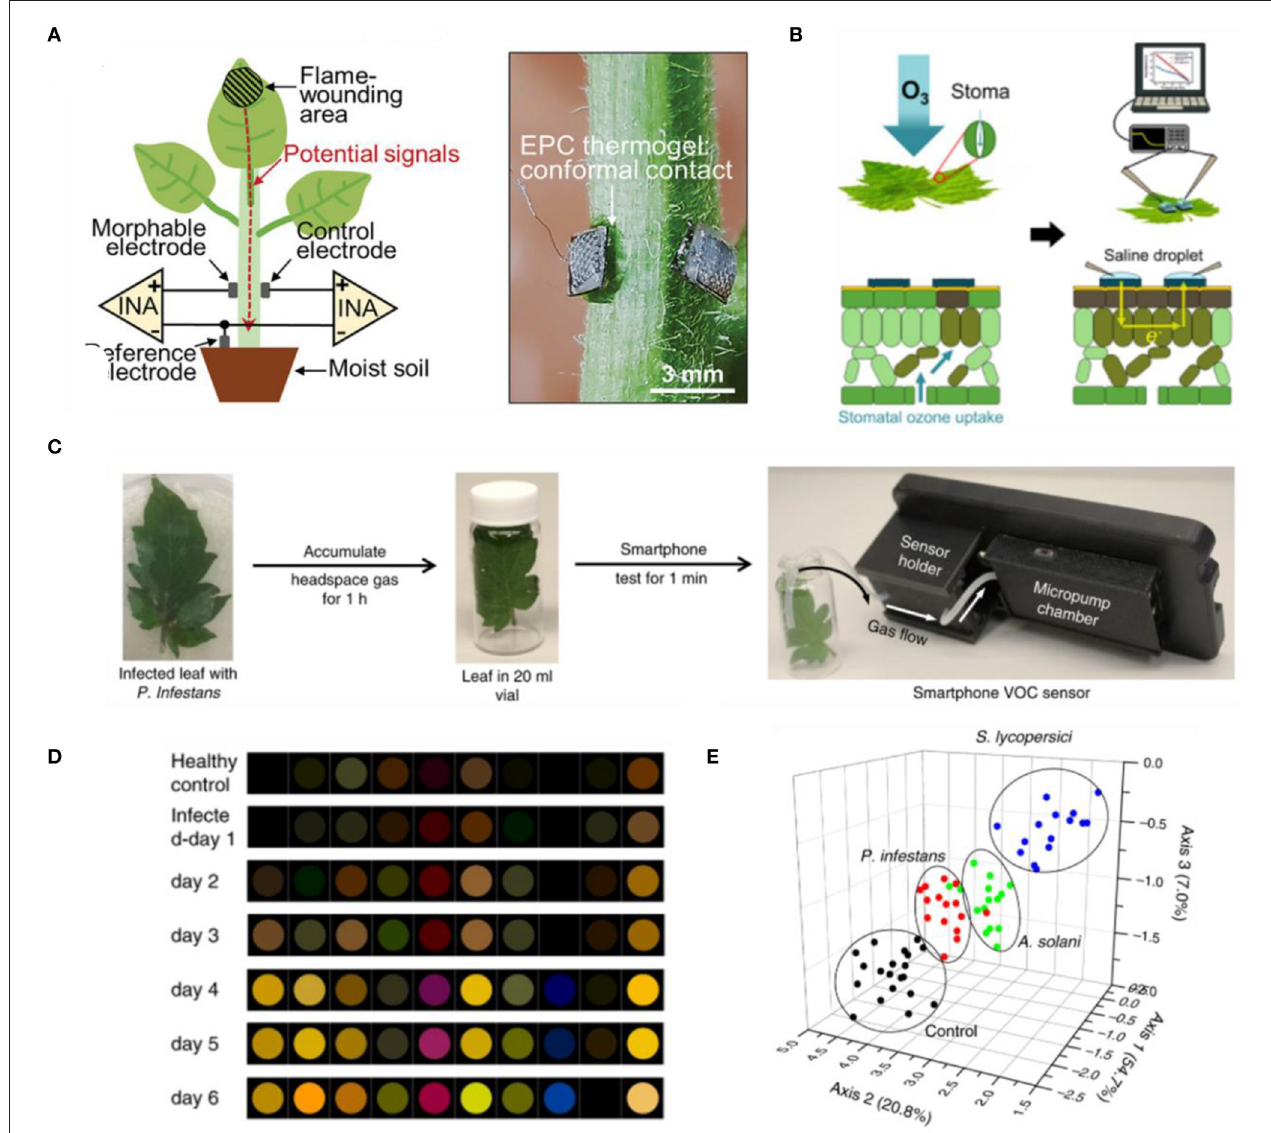
FIGURE 2 | (A) Thermogel application to monitor electrical potential signals from plants with hairy stems (Luo et al., 2021). (B) Printed conductive polymers enabled impedance spectroscopy to detect ozone damage (Kim et al., 2020). (C) Detection of plant VOCs using smartphone-integrated chemical sensor arrays (Li et al., 2019). (D) Differential colorimetic response of sensor arrays upon exposure to tomato plants infected with Pseudomonas infestans (Li et al., 2019). (E) Principal Component Analysis (PCA) plot to distinguish pathogenic infections on tomato plants based on chemical sensor arrays (Li et al., 2019).